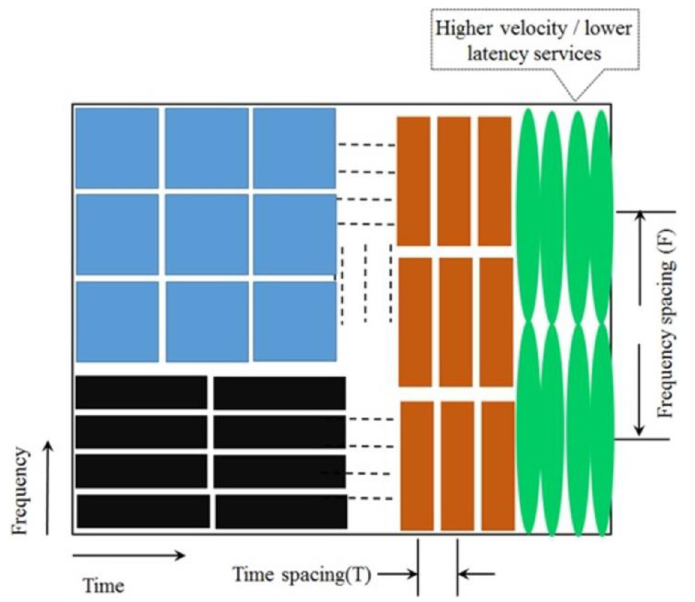
Fig 1. Different time-frequency allocation of sub-carriers in wireless air